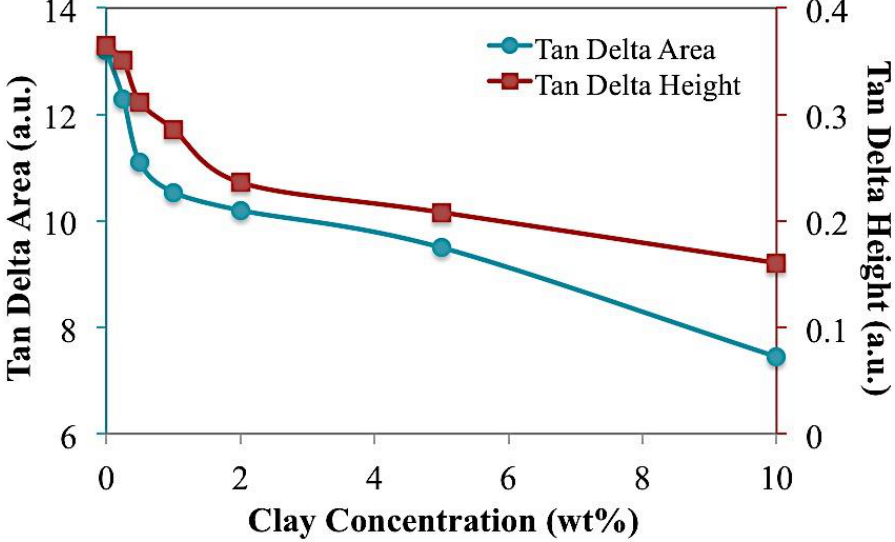
Figure 11. Effect of clay wt.% on the damping ability (tan δ peak area) of the nanocomposites.